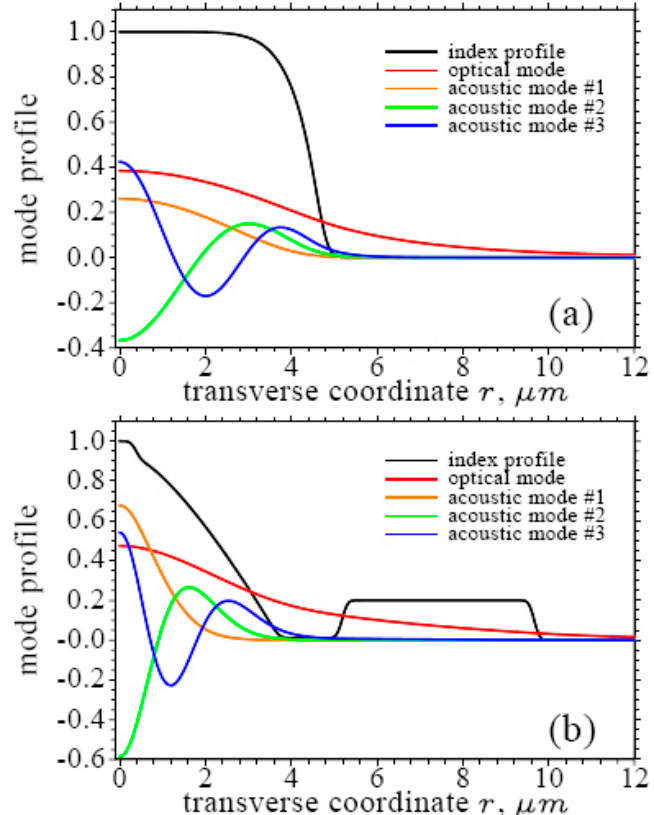
Figure 5. The electric mode and acoustic mode under different profiles. (a) The profiles of the single mode fiber, (b) The profile of Corning large effective area fiber. [Reprinted/Adapted] with permission from [65] © The Optical Society.